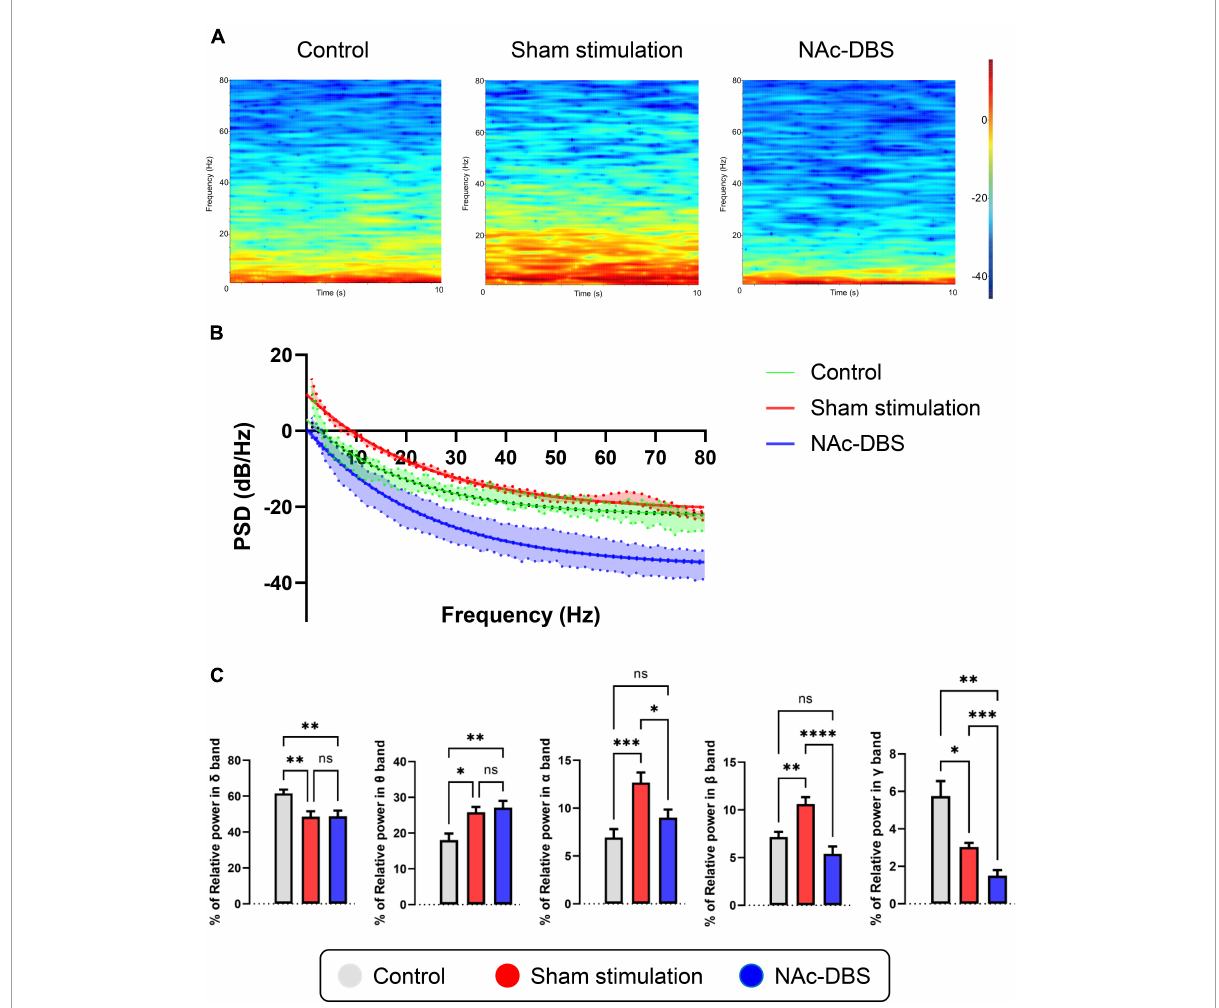
FIGURE5 Illustrations of the difference in LFP activity in the NAc. (A) Representative time-frequency spectrograms in 10 s showing the power level of LFP from 1 to 80 Hz in the NAc of the control, sham stimulation and NAc-DBS groups. (B) The mean PSD curve with 95% confidence interval from 1 to 80 Hz. (C) The bar graphs represent the mean level of relative LFP powers of the delta band, theta band, alpha band, beta band and gamma band in the NAc in the different group. PSD, power spectral density. The data are presented as the mean ± SEM; n = 8 vs. n = 34 vs. n =